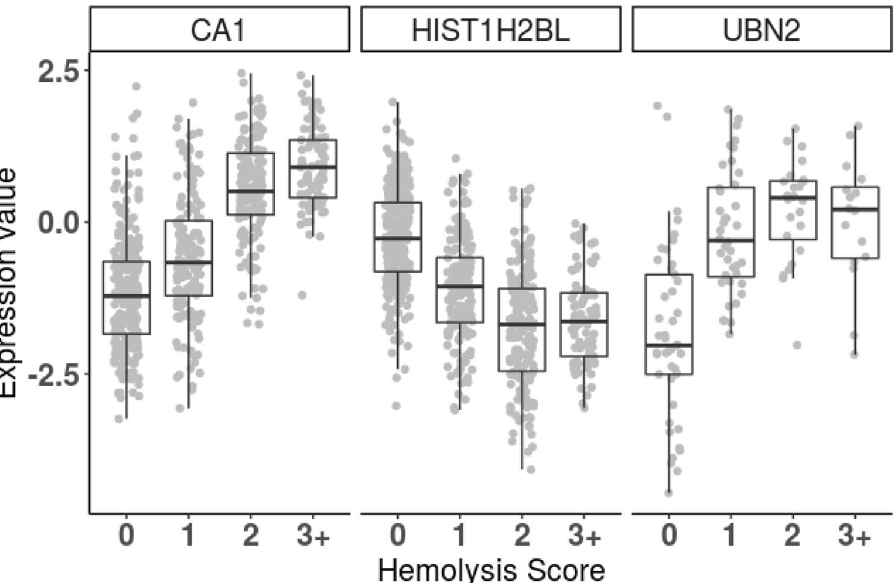
Figure 6. is a boxplot of buffy coat proteins expressions of (CA1 = Carbonic anhydrase, HIST1H2BL = Histone H2B type 1-L, UBN2 = Ubinuclein-2) that were identified as significantly differentially expressed proteins in comparison to their Hemolysis score of 0, 1, 2 and 3+. Expression values are log2 ratio to the reference sample. CA1 protein comparison between 0 versus 1 with an adjusted p value of 5.54E −07 , comparison of 0 versus 2 with adjusted p value of 1.56e −53 and comparison of 0 versus 3 with adjusted p value of 3.27e −50 . UBN2 protein comparison between 0 versus 1 with adjusted p value of 4.57e −07 , comparison of 0 versus 2 with adjusted p value of 2.88e −08 and comparison of 0 versus 3 with adjusted p value of 5.42e −05 . H2BC13 protein comparison between 0 versus 1 with adjusted p value of 2.72e −18 , whereas comparison of 0 versus 2 with adjusted p value of 2.60e −45 and comparison of 0 versus 3 with adjusted p value of 3.12e −31